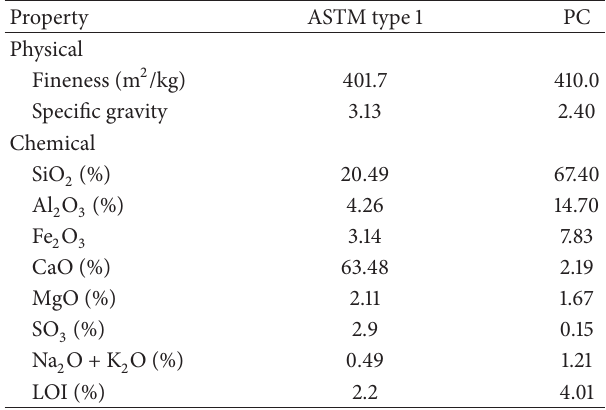
Table 1: Physical and chemical properties of Portland cement and pyroprocessed clay